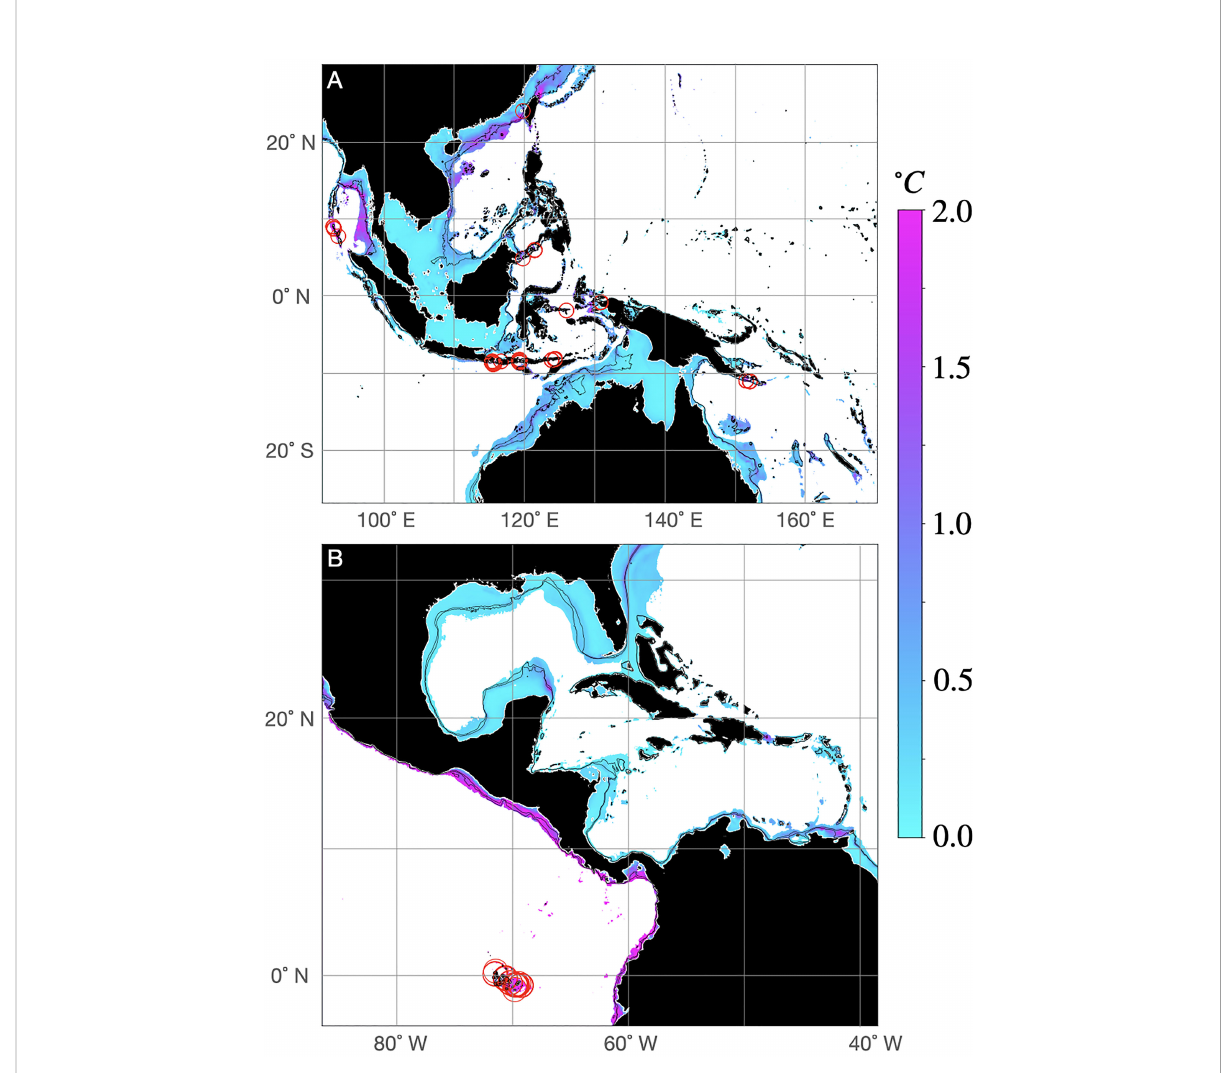
FIGURE 3 Mean daily temperature range at 50 m depth, shown only for locations shallower than 1000 m in (A) the western Paci fi c and (B) eastern Paci fi c/ Caribbean. The 100m and 200m isolines are indicated by thin black lines. Red circles indicate locations where the daily temperature range at 10m depth exceeds